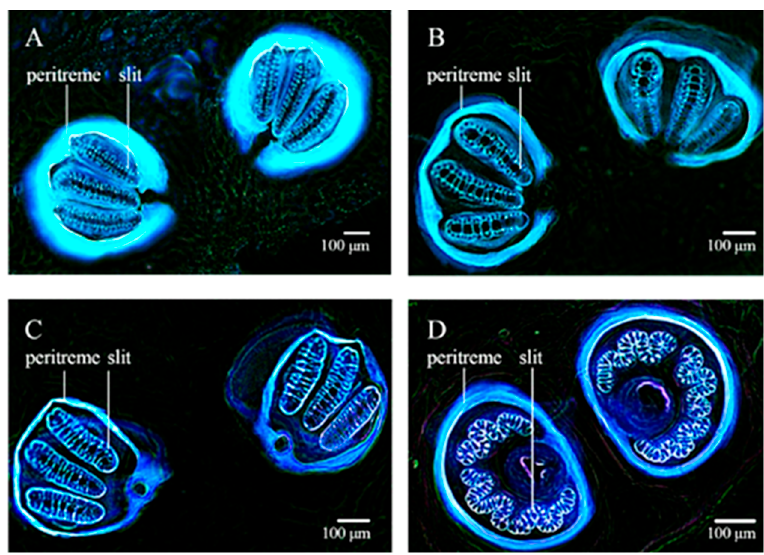
Figure 11. Inverted image colors showing the larval posterior spiracles of ( A ) Chrysomya ruffifacies (Macquart) ; ( B ) C. megacephala; ( C ) L. cuprina ; ( D ) M. domestica. The morphological differences in